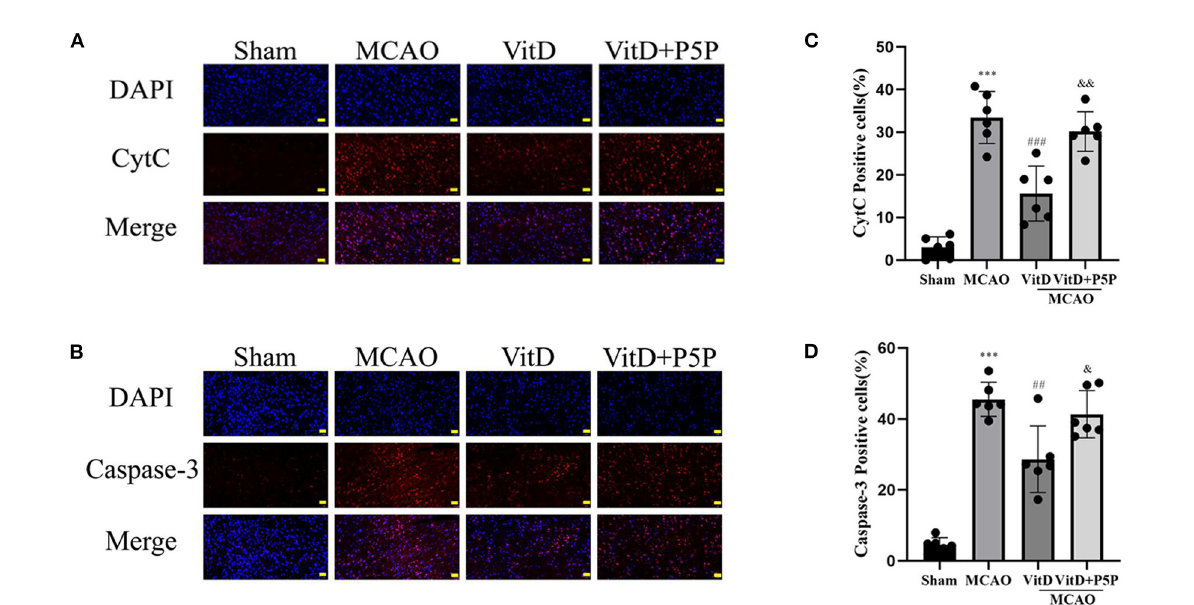
FIGURE5 1,25-D3 (Vit D) can inhibit the expression of mitochondrial apoptotic proteins after cerebral ischemia-reperfusion injury. (A,B) In situ expression of CytC (red), caspase-3 (red) in the peri-infarct region of sham-operated, MCAO/R, DMSO, 1,25-D3, and P5P groups. DAPI (blue). (C,D) The percentage of positive cells was calculated. Scale bar = 50 µ m. All values are shown as the mean ± SEM. *** P < 0.001 (vs. Sham), ## P < 0.01, ### P < 0.001 (vs. MCAO), & P < 0.05, && P < 0.01 (vs. VitD), n = 5. P5P, antagonist of VDR; Vit D,